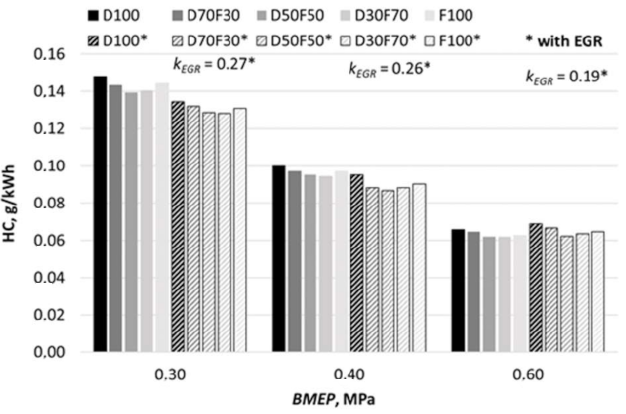
Figure 17. Dependence of hydrocarbon (HC) emissions on fuel composition and the engine load.